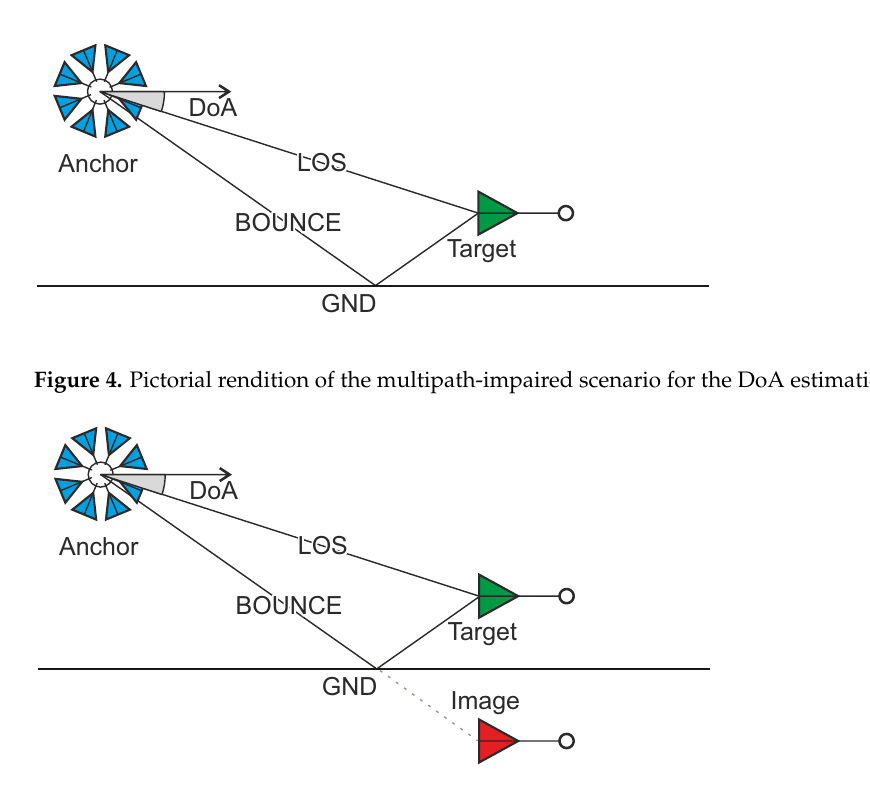
Figure 5. Pictorial rendition of multi-path propagation using an image-source